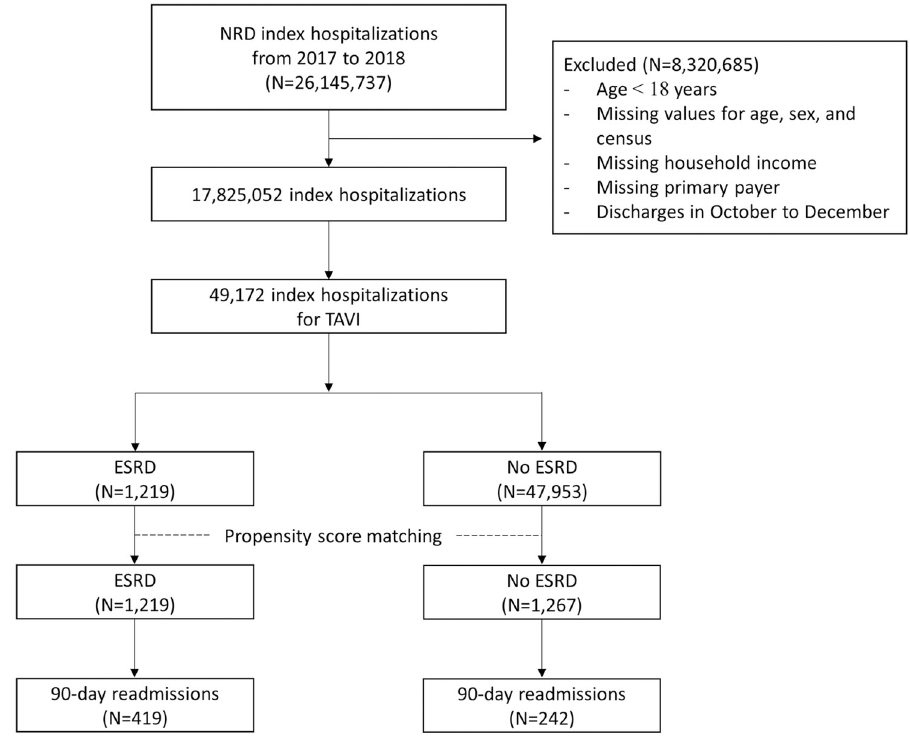
Fig 1. Study flow chart. Fig 1 shows the selection process of the index hospitalizations for TAVR from NRD 2017 to 2018, which are then stratified to those with and without a co-diagnosis of ESRD.